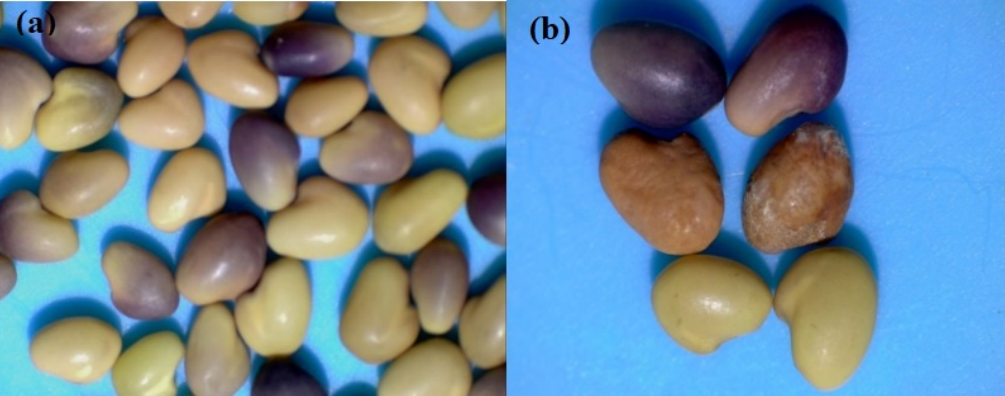
Figure 1. Variation of colors in a natural red clover seed lot ( a ); seeds of yellow, brown, and dark purple colors selected for the study ( b ).